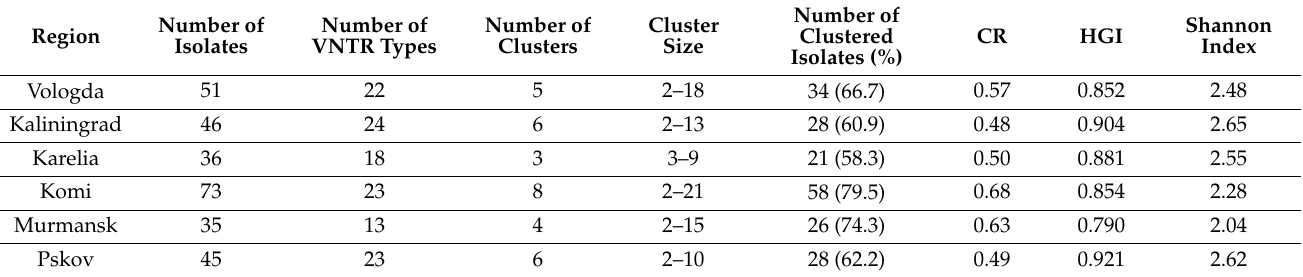
Table 4. Regional VNTR-based diversity of M. tuberculosis Beijing genotype